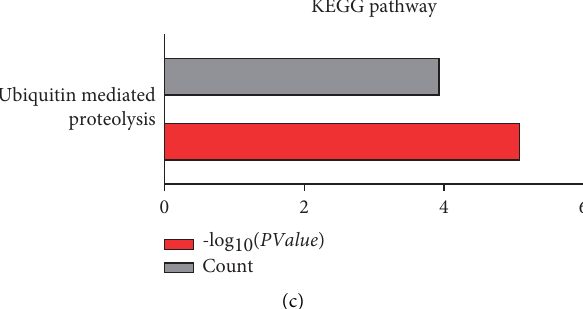
Figure 6: The circRNA-miRNA-hub gene regulatory subnetwork and functional enrichment analysis of the hub genes. (a) circRNA- miRNA-hub gene regulatory subnetwork. The shape of V represents circRNAs, triangle represents miRNA, and ellipse represents mRNA. The red and green indicate upregulated expression and downregulated expression, respectively. (b) GO enrichment analysis. Note . Circle represents BP, square represents MF, and triangle represents CC. The size of shapes represents gene counts. The color shows the P value, and the horizontal bar represents the corresponding P values. (c) KEGG pathway analysis. The abbreviations are the same as in Figure 2. Table 2: Basic information of circRNAs involved in the subnetwork.